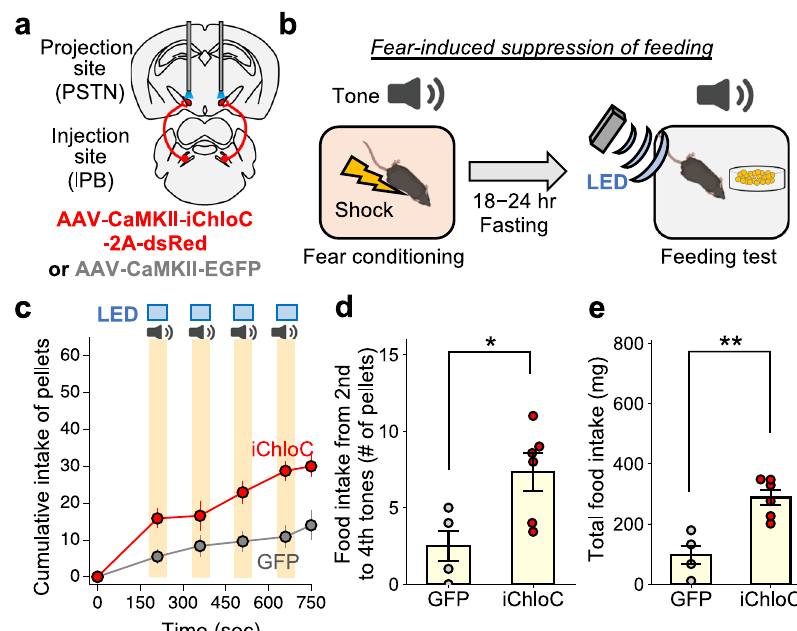
Fig. 5 | Inhibition of the lPB-PSTN pathway attenuates fear-induced suppres- sion of feeding. a Schematic of microinjection and placement of the LED cannula unitoftheC57BL/6Jmouse. b Schematicillustrationoffear-inducedsuppressionof feeding. c Cumulative number of small food pellets ingested by mice during the feeding test (GFP, n =4; iChloC, n =6). d The averaged pellet intake from 2nd tone